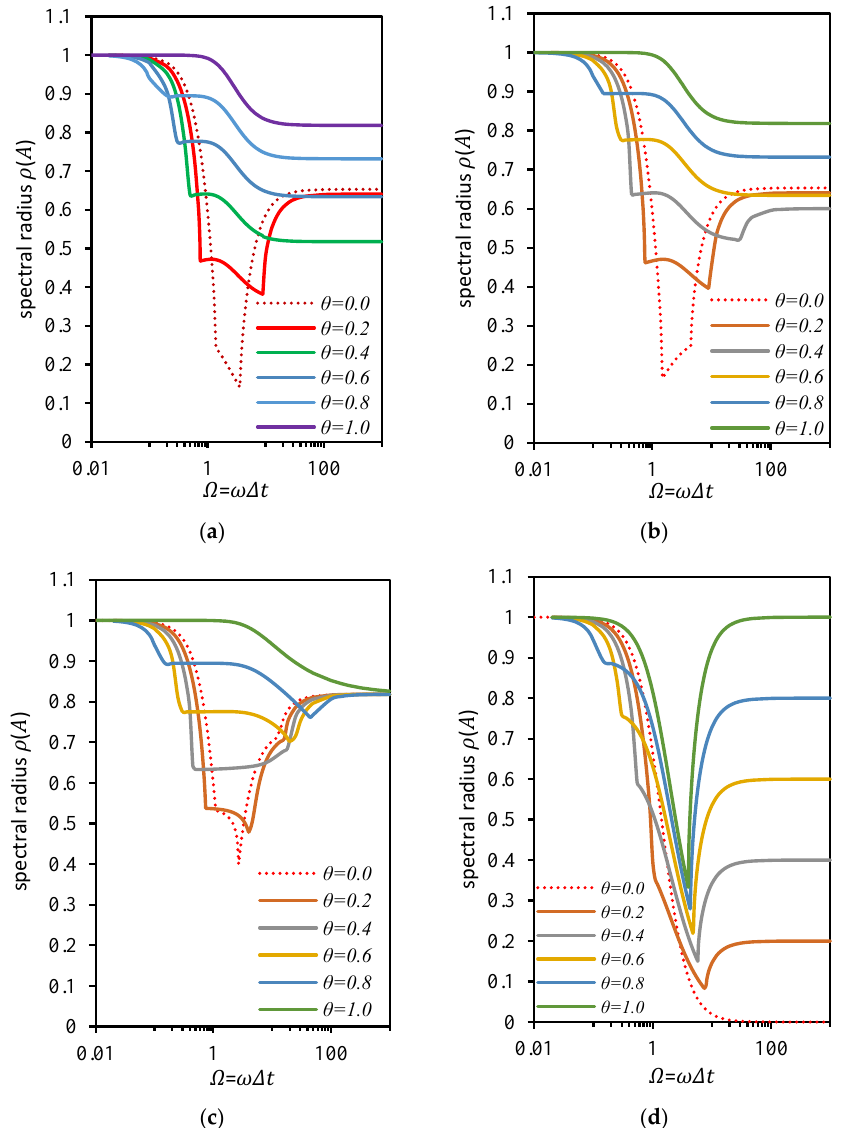
Figure 5. Spectral radius of the algorithms with different values of θ : ( a ) G- α 1 method; ( b ) G- α 2 method; ( c ) G- α 0 method; ( d ) NMK- α method.